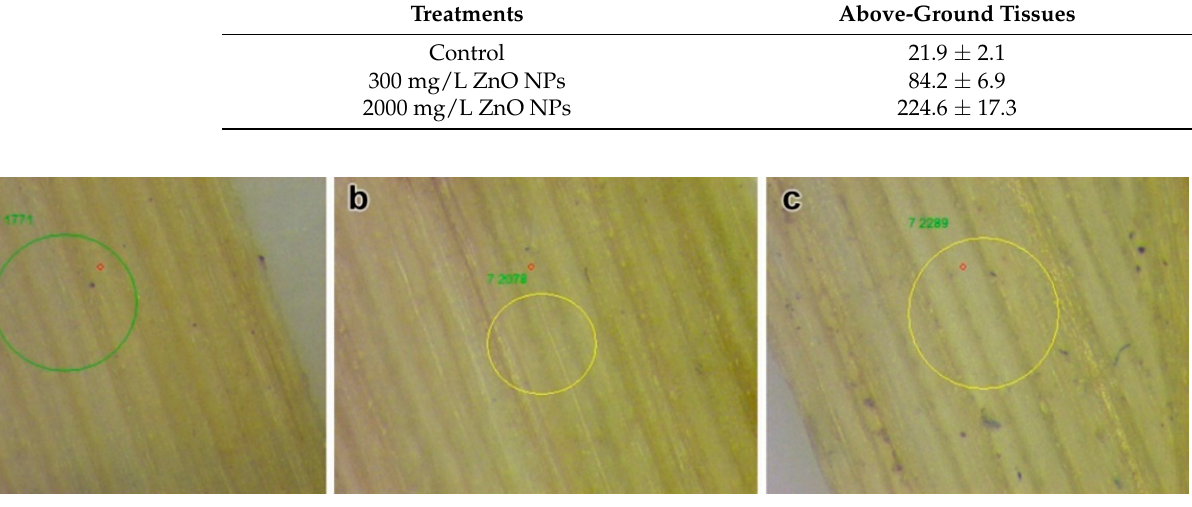
Figure 5. Chlorophyll fluorescence kinetics in H. sativum leaves from plants germinated in the presence of different ZnO NP concentrations . Photoinduction curves averaged over 8 repetitions are shown. (a) 0 mg/L ZnO NPs (control); (b ) 300 mg/L ZnO NPs; ( c) 2000 mg/L ZnO NPs. F p —peak (maximal) fluorescence level; F s —steady-state fluorescence level. Curves were normalized by F p . Fluorescence decrease ratios, R fd = (F p − F s )/F s , mean ± SD, were R fd 0 = 0.87 ± 0.05, R fd 300 = 0.45 ± 0.03, and R fd 2000 = 0.16 ± 0.02 at p = 0.05, n = 8 .